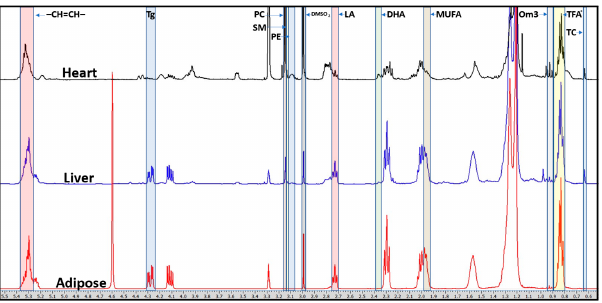
Figure 1. Representative cardiac, hepatic, and adipose lipid spectra obtained from a male Nile grass rat fed with a high-fat, time-restricted, evening feeding diet using proton nuclear magnetic resonance ( 1 H-NMR) spectroscopy. Complete reduction to amplitude–frequency table (CRAFT) fingerprints are shown for targeted lipid resonances. Abbreviations: Tg, triglycerides; PC, phosphatidylcholine; SM, sphingomyelin; PE, phosphatidylethanolamine; DMSO 2 , dimethyl sulfone; LA, linoleic acid; DHA, docosahexaenoic acid; MUFA, monounsaturated fatty acids; Om3, omega-3 fatty acids; TFA (TFA* + Om3), total fatty acids; TC, total cholesterol; –CH=CH–, olefinic